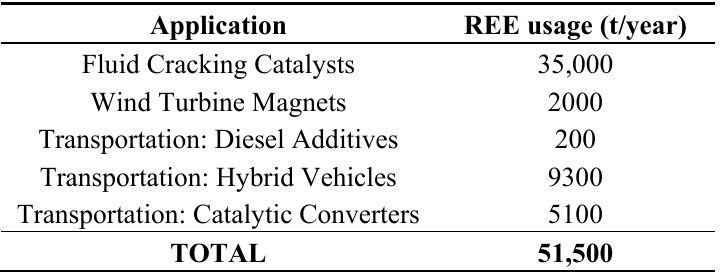
Table 2. Global REE consumption by energy